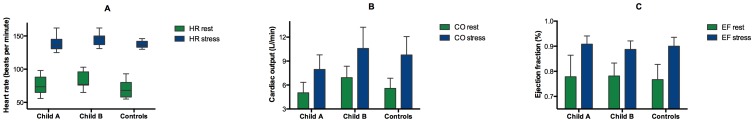
Response to dobutamine stress test.The figures show the response regarding heart rate (A), cardiac output (B) and ejection fraction (C) from rest to stress during maximal dobutamine infusion in Child A patients, Child B patients and controls. The bars show 95% confidence interval. Figure 2a: all groups show a similar significant increase in heart rate. Figure 2b: all groups show a similar significant increase in cardiac output. Cardiac output was significantly higher at rest in Child B patients compared to Child A patients, p<0.01. Figure 2c: all groups show a similar significant increase in ejection fraction.